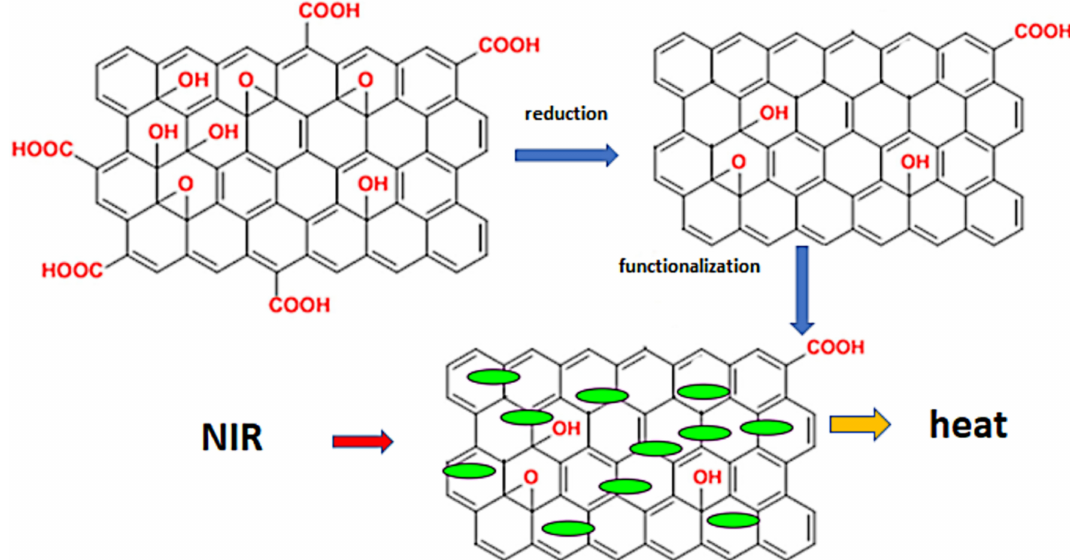
Figure 3. The principal of phototherapy. Legend: When using GO, it must first be reduced to rGO and functionalized with various substances (human serum proteins, hyaluronic acid, and pharmaceuticals). The functionalized rGO is then exposed to NIR and releases